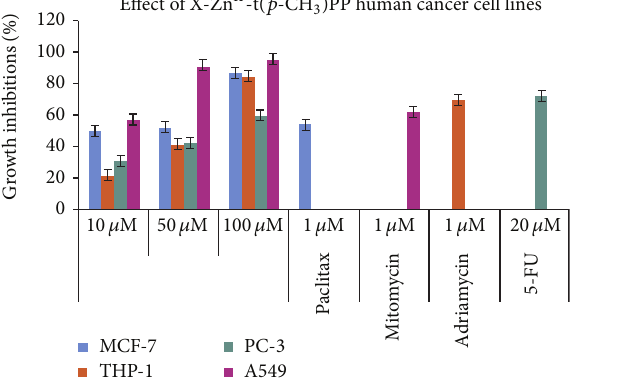
Figure 7: In vitro cytotoxicity of p -NO 2 phO-Zn-t( p -CH 3 )PP com- plexes against human cancer cell lines.